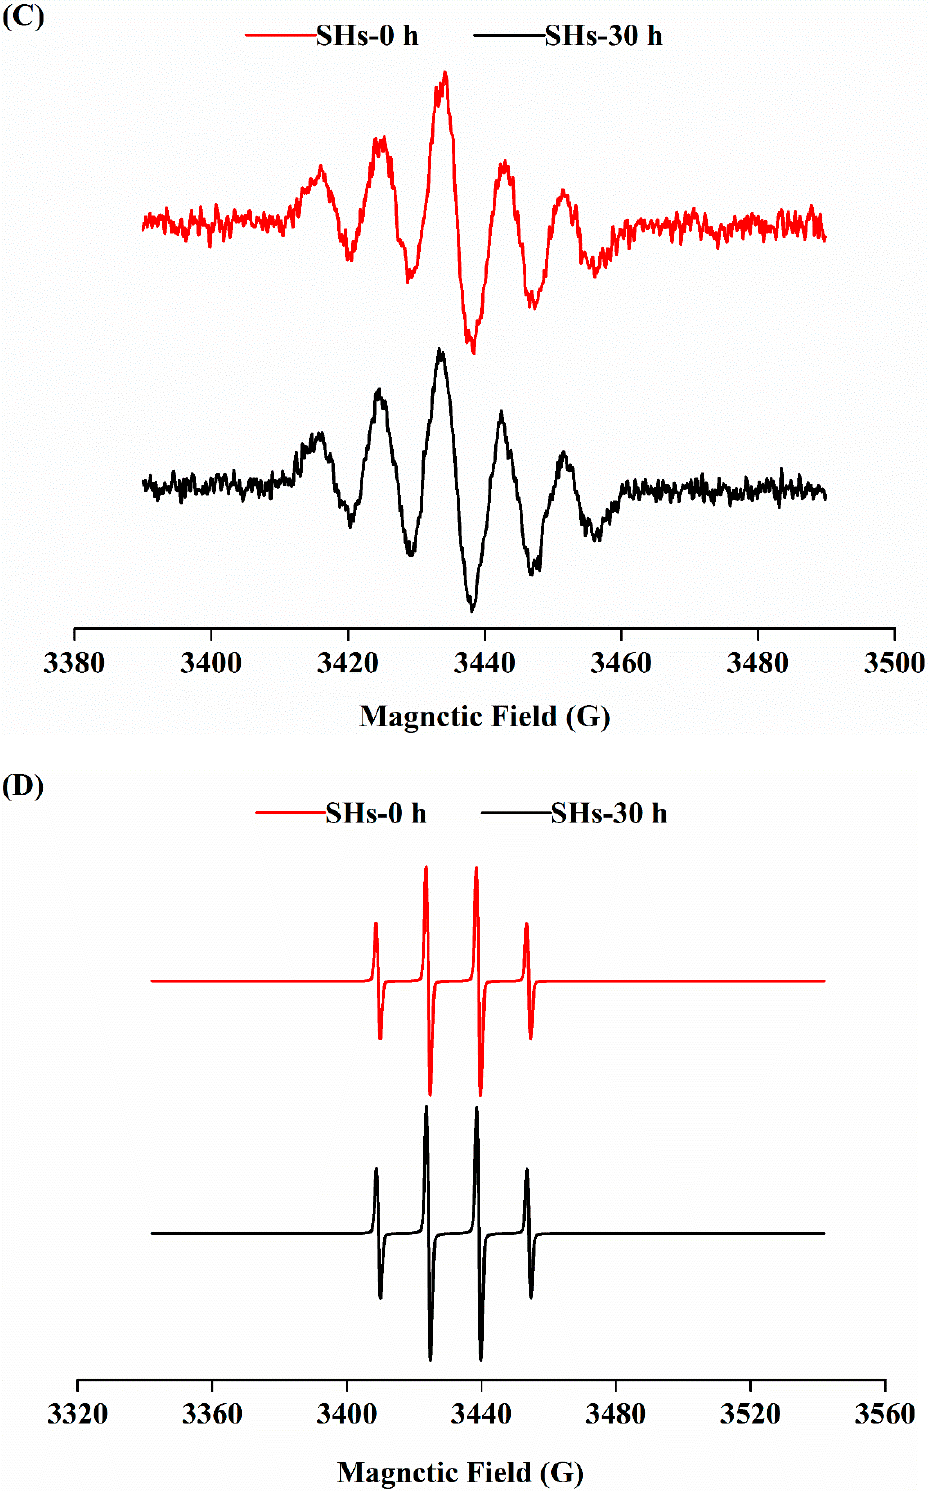
Figure 3. ( A ) Surface structure changes observed by SEM (1000× and 5000×). ( B ) The DPPH and OH radical scavenging rate of SHs-0 h and SHs-30 h. ( C ) The EPR spectra of DPPH radical scavenging ability. ( D ) The EPR spectra of OH radical scavenging ability.